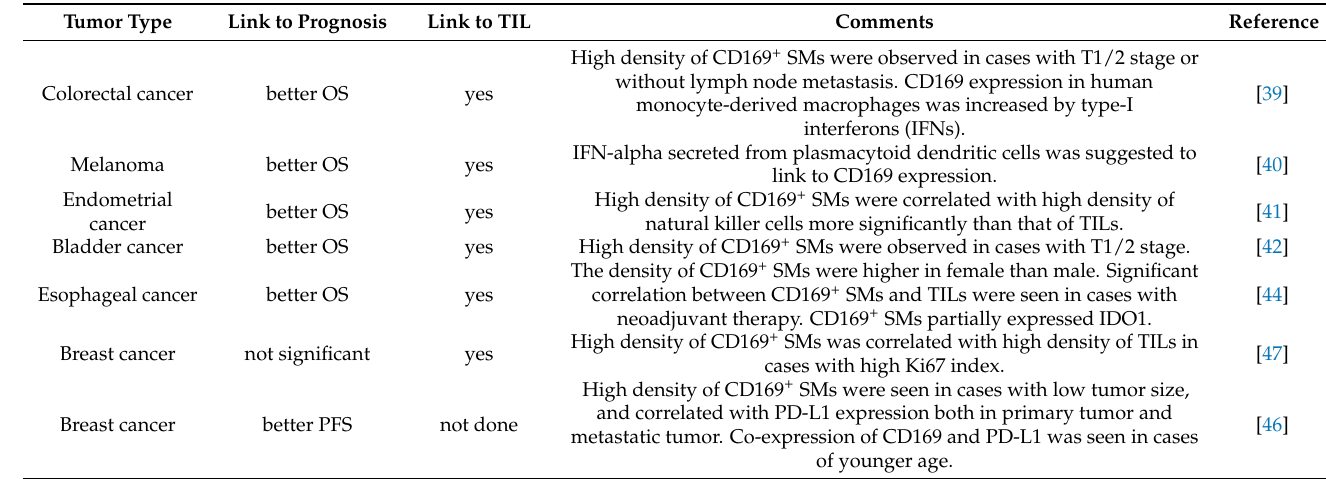
Table 1. Clinical significance of CD169 + sinus macrophages (SMs) in solid